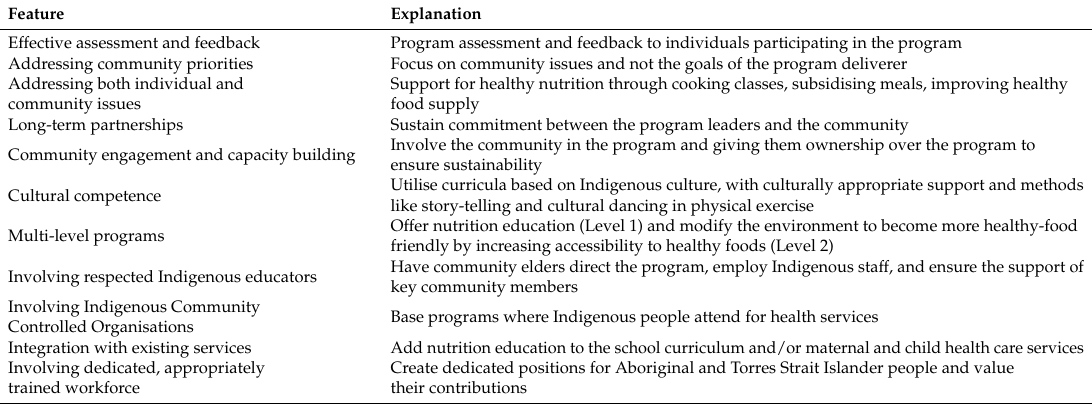
Table 1. Common features of successful nutrition